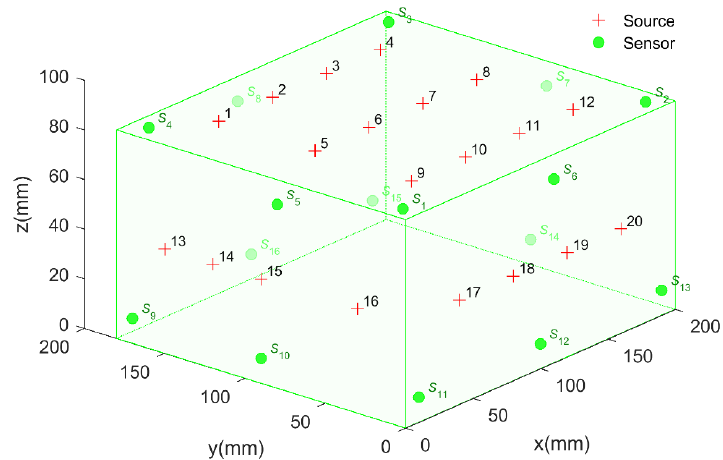
Figure 3. The layout of the AE sensors and sources in the pencil lead break experiment.